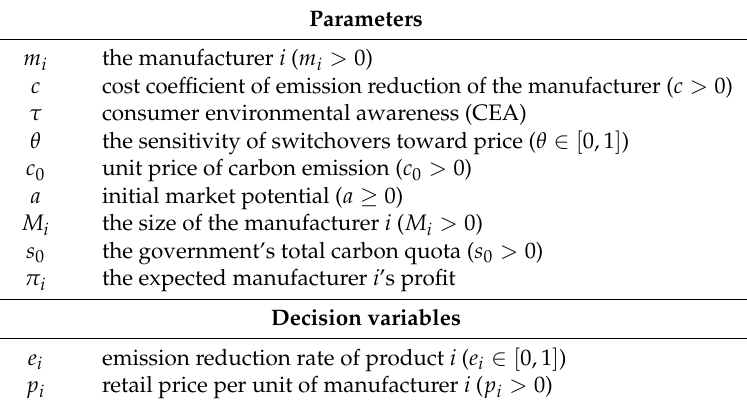
Table 2. Model parameters and Decision variables (in this paper, right subscript i = 1, 2). Parameters